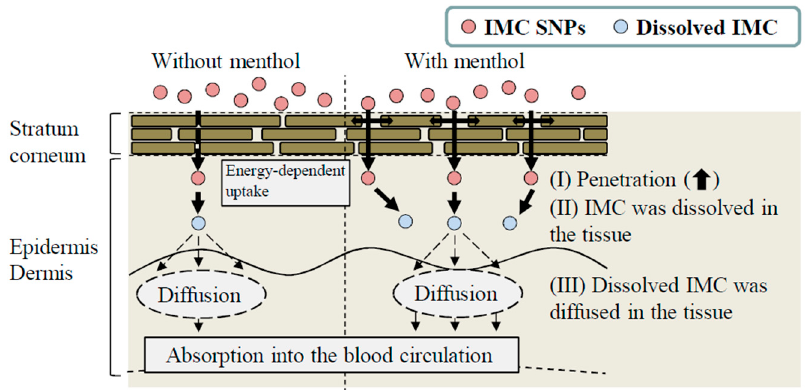
Figure 7. The mechanism for the percutaneous absorption process by the combination of IMC SNPs and l-menthol.